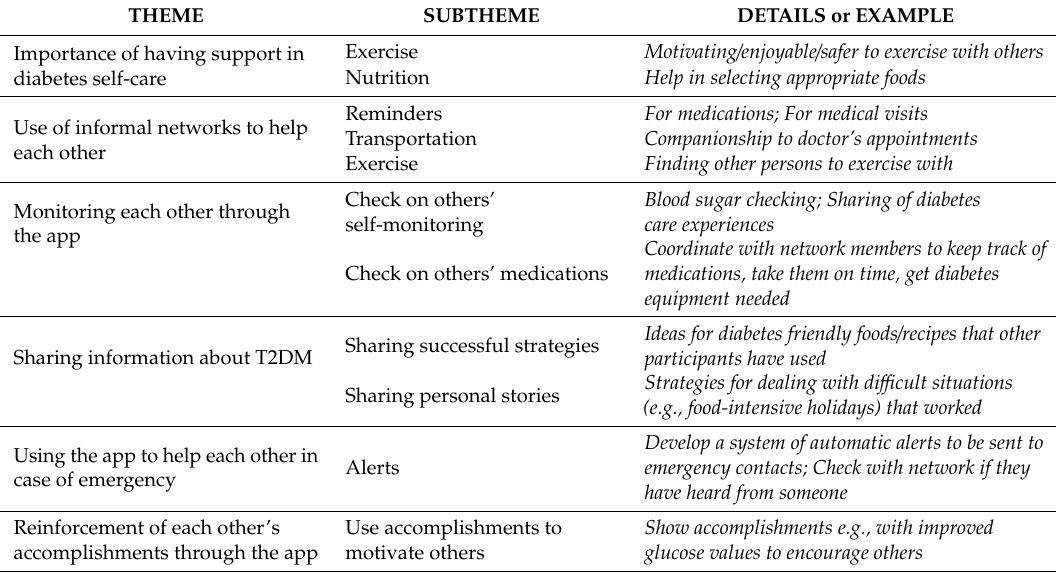
Table 2. Summary of themes and subthemes that emerged from the